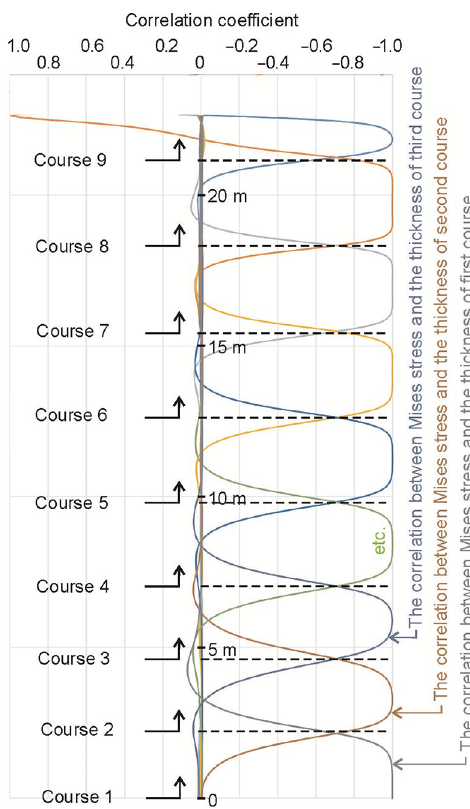
Fig. 12. Correlation between thickness t stress state SEQV for model